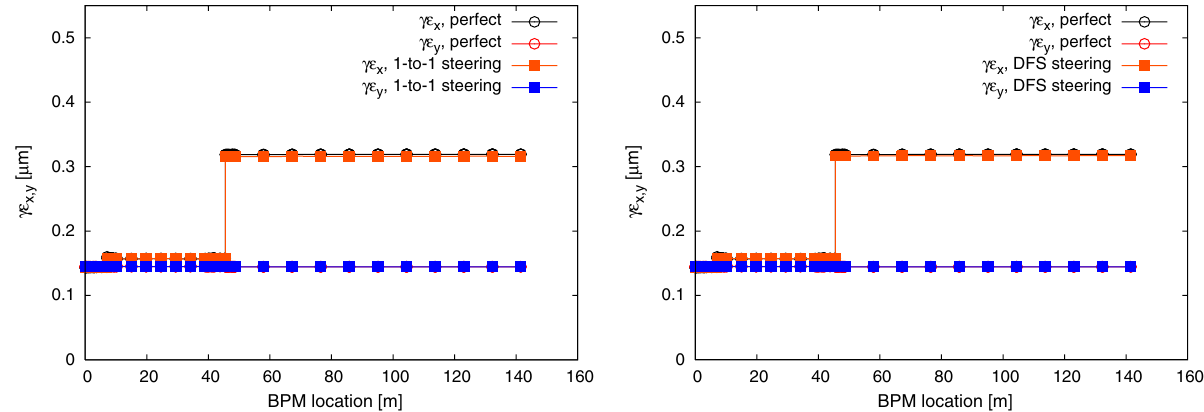
FIG. 8. Left: After one iteration of one-to-one steering, dispersive and chromatic emittance dilution (energy spread correlated) is suppressed. Right: After one iteration of dispersion free steering, dispersive and chromatic emittance dilution (energy spread correlated) is suppressed. In the simulation 200 (cid:1) m (rms) random offsets are applied on all the quadrupoles and rf structures, and 200 (cid:1) m is assumed for the offset between BPM electrical center and quadrupole magnetic center. The result is an average of 100 random error